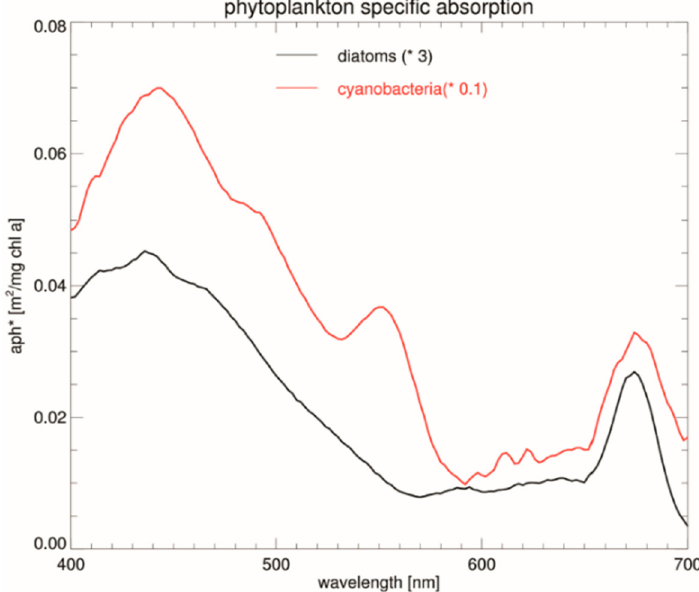
Figure 8. The spectra of pigment ‐ specific phytoplankton absorption determined in marine water samples (reproduced after [42]). Symbols: cyanobacteria (red) and diatoms (black). samples (reproduced after [42]). Symbols: cyanobacteria (red) and diatoms